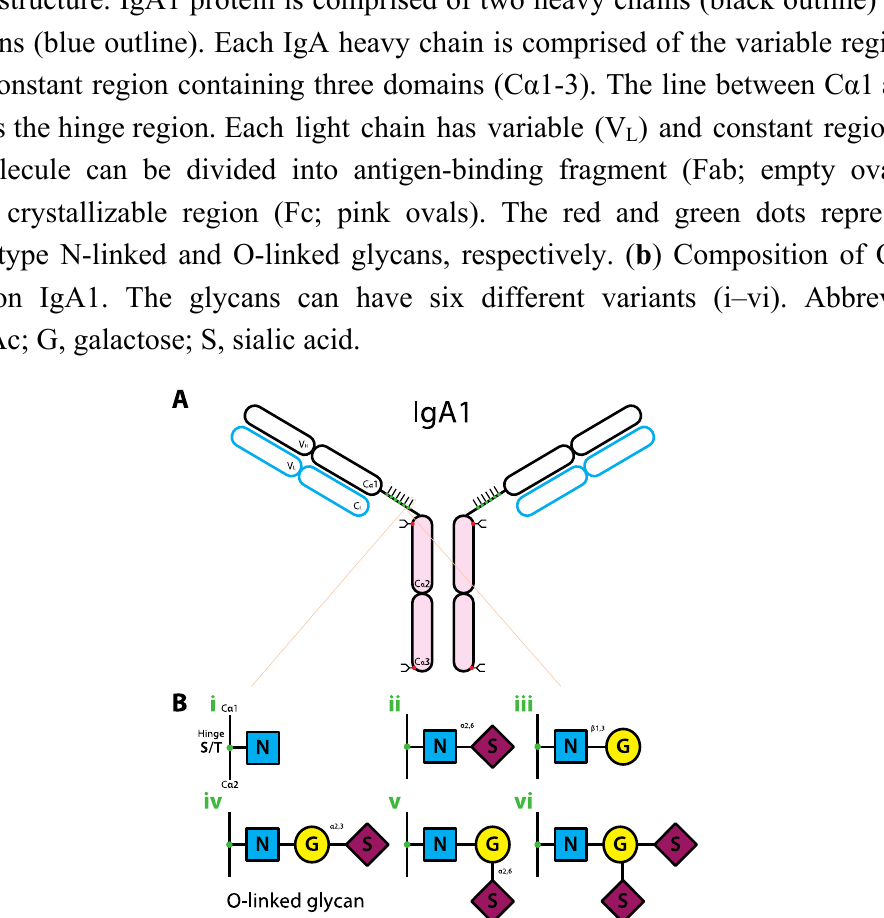
) H ) and constant regions (C ). L L